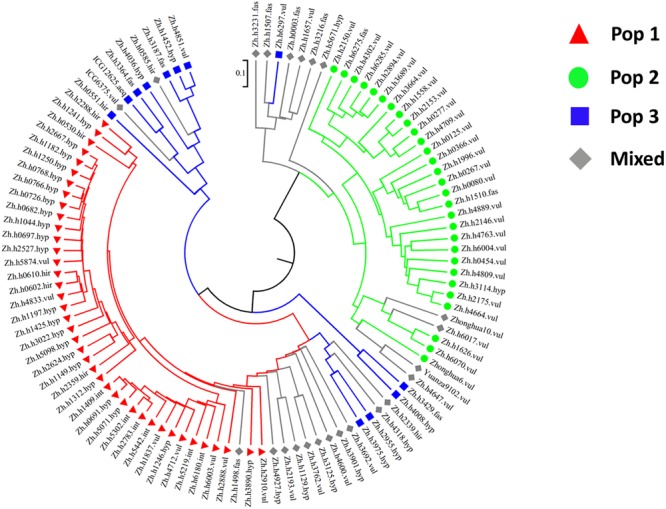
Dendrogram of the peanut panel based on SSR genotyping data.